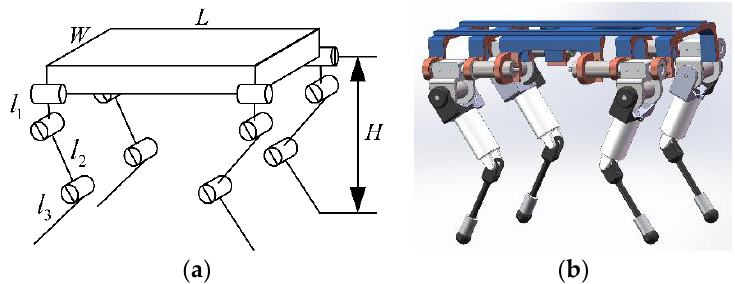
Figure 12. ( a ) Simplified; and ( b ) mechanical models of the quadruped robot.